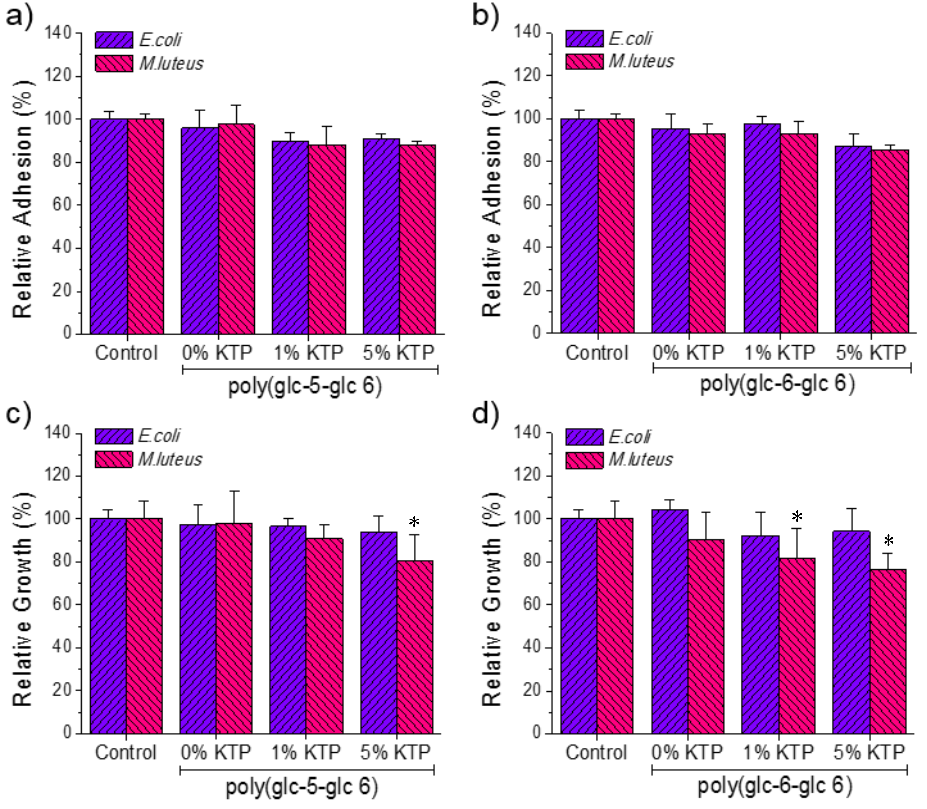
Figure 11. Results of bacterial adhesion ( a , b ) and proliferation ( c , d ) assays performed on the prepared poly(glc-5-glc 6) ( a , c ) and poly(glc-6-glc 6) ( b , d ) scaffolds using E. coli and M. luteus. * p < 0.05 versus